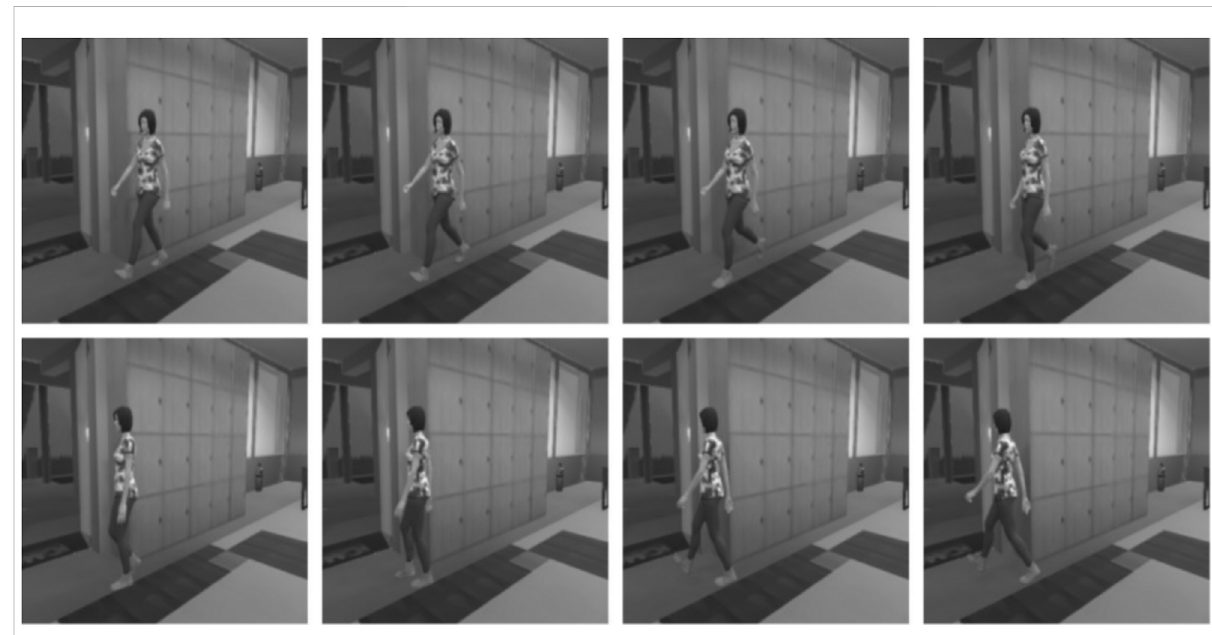
FIGURE 4 Grayscale imagesthat are part ofthe state S im . The sequential imageshelpthe robot learn according to thedirection ofhuman movement. The sequence goes from left to right, top to